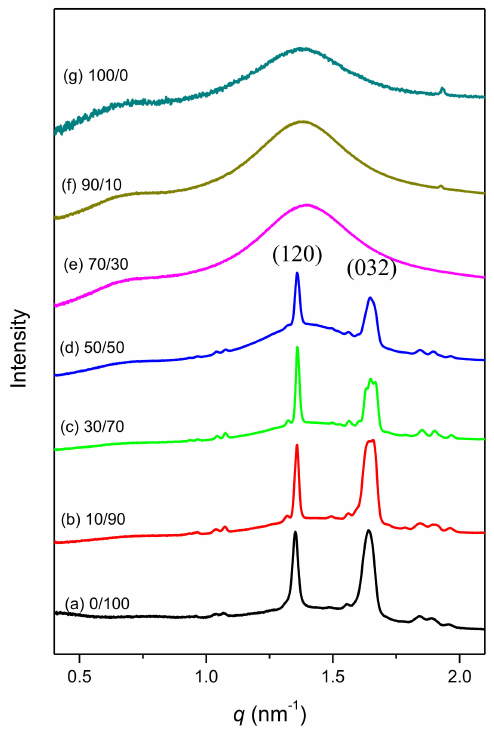
Figure 8. WAXD analyses of PS- b -PVPh/PEO- b -P4VP mixture at room temperature of (a) 0/100, (b)